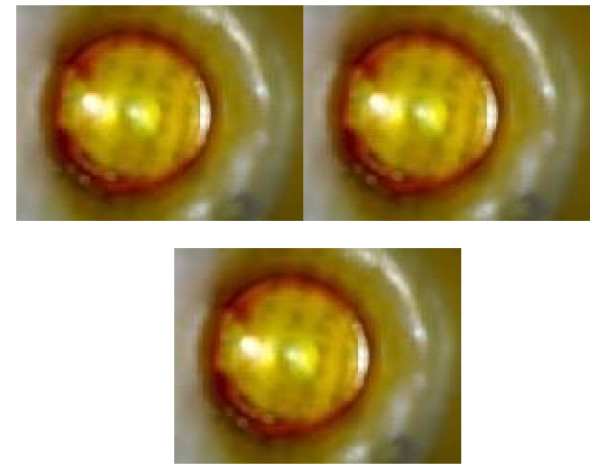
Optical images of the polystyrene maleimide-SiO2/TiO2 hybrid nanocomposites.